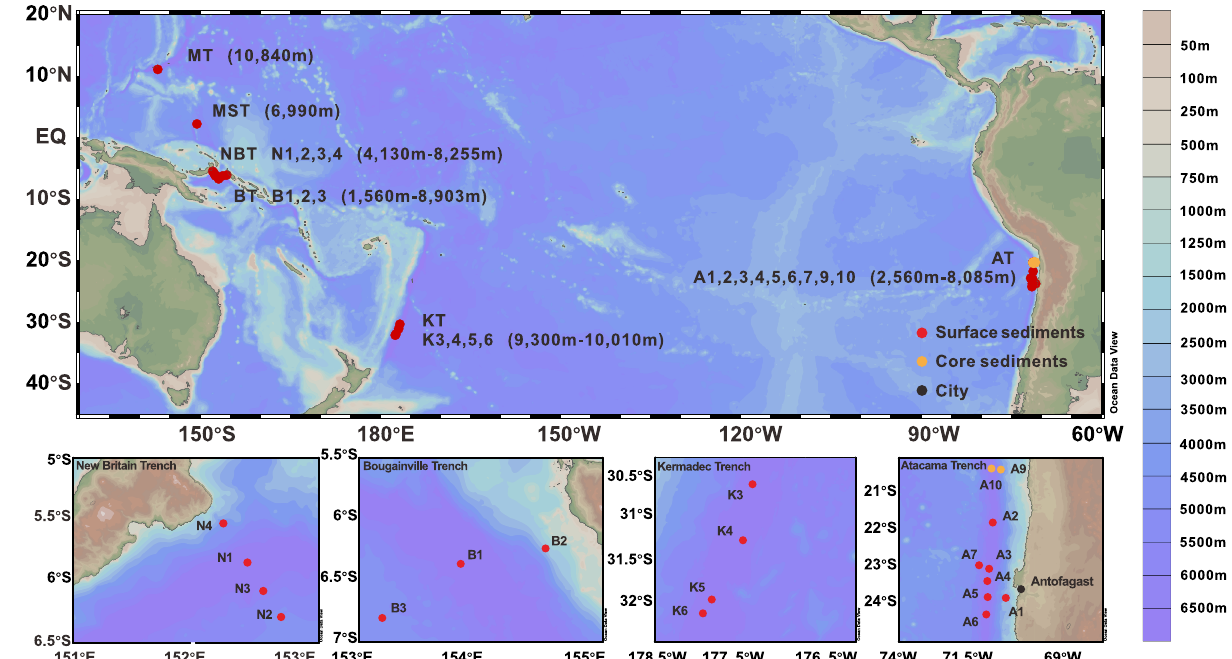
Fig. 1 Map showing sampling sites of six trench regions in the Paci fi c Ocean. The site information is summarized in Supplementary Table 1. The numbers in bracket denote water depth range at each trench. MT Mariana Trench, MST Mussau Trench, NBT New Britain Trench, BT Bougainville Trench, KT Kermadec Trench, AT Atacama Trench. Base map was drawn using the Ocean Data View software package 63 .